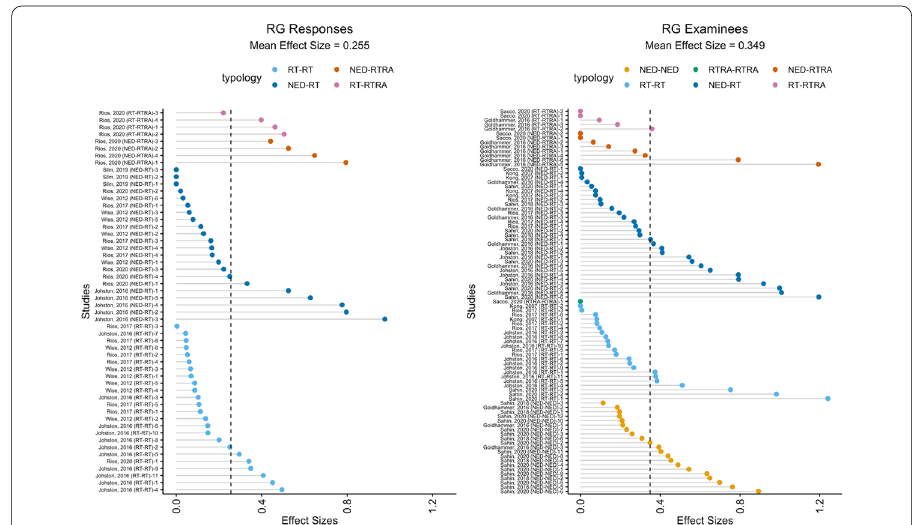
Fig. 3 Effect size based on RT typology pairing for descriptive outcomes. RG responses responses identified, RG examinees proportion of examinees engaging in